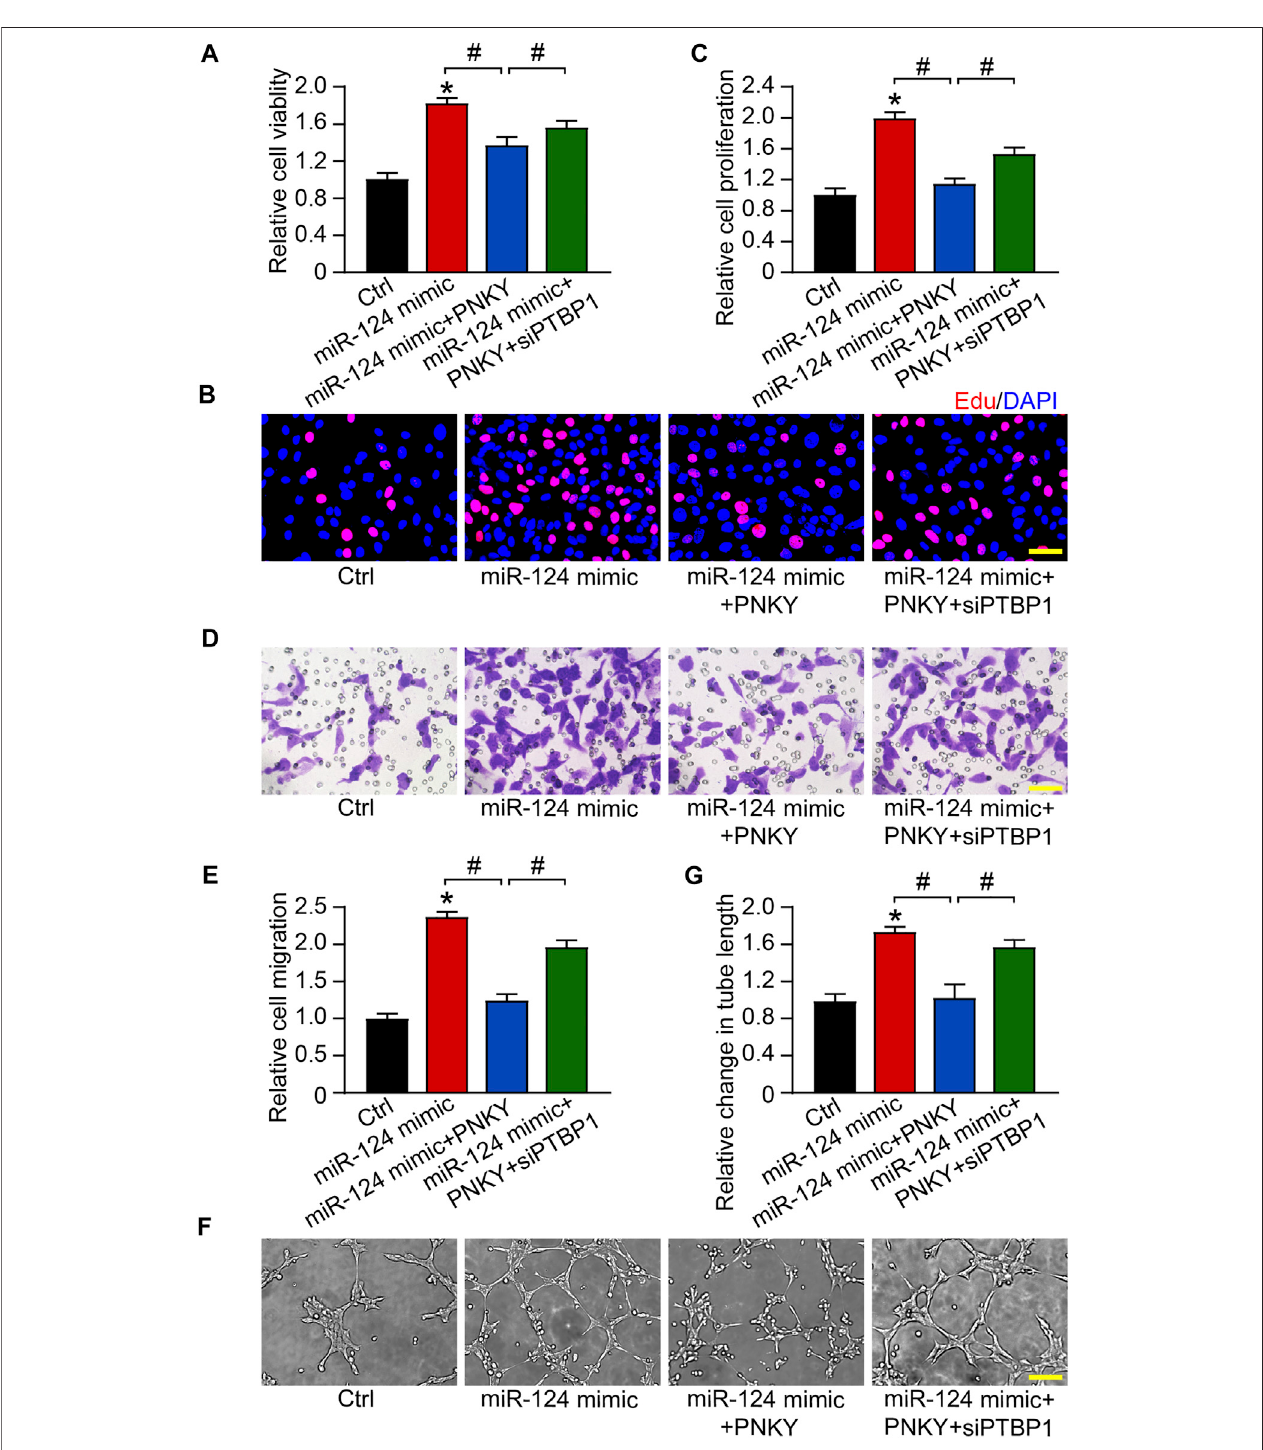
FIGURE7| PNKY – PTBP1/miR-124interactionregulatesthefunctionofRF/6Acells.RF/6AcellsweretransfectedwithscrambledmiR-124mimic,miR-124mimic plus pcDNA3.0-PNKY, miR-124 mimic plus pcDNA3.0-PNKY and PTBP1 siRNA, or left untreated (Ctrl) for 24 h before further processed. (A) Cell viability was determined using MTT method ( n = 4). (B,C) Cell proliferation was detected with EdU staining and quanti fi ed. Blue: DAPI; red: EdU (Scale bar, 50 μ m, n = 4). (D,E) The migration of RF/6A cells was detected using Transwell assay and quanti fi ed (Scale bar, 50 μ m, n = 4). (F,G) The tube-like structures were observed 4 h after cell seeding on the matrix, and the average length of tube formation for each fi eld was statistically analyzed (Scale bar, 200 μ m, n = 4). All signi fi cant difference was determined by one-way ANOVA followed by Bonferroni ’ s post hoc test. * p < 0.05 versus Ctrl, # p < 0.05 between the marked groups.